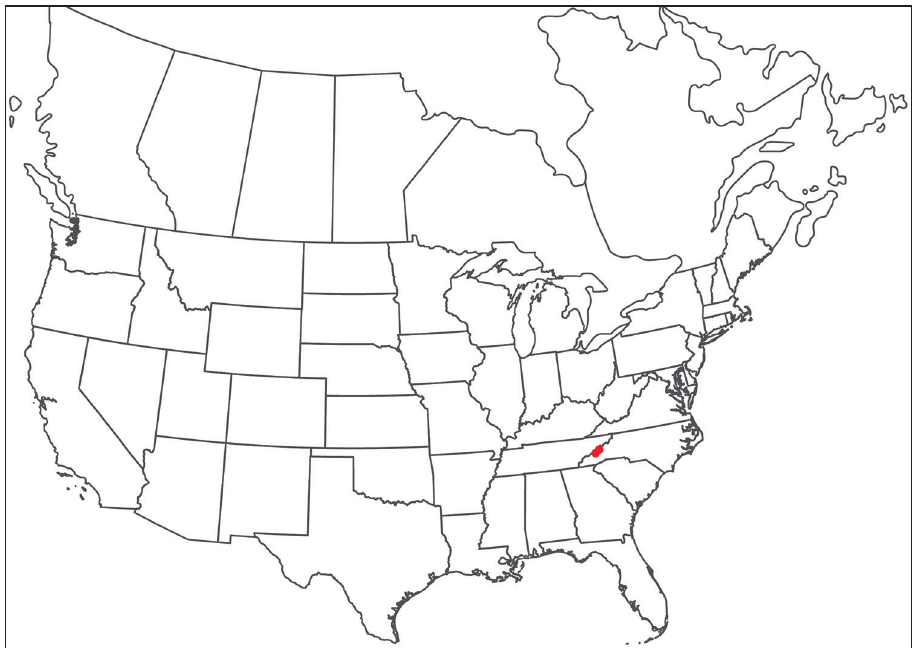
Figure 32. Torrenticola bondi sp. n.